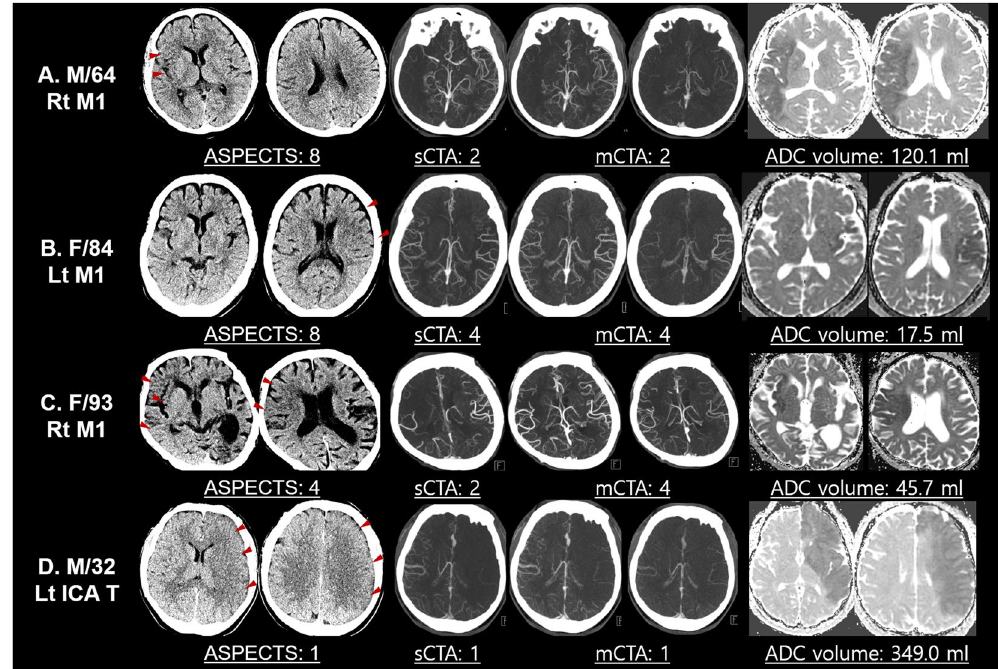
Figure 2. Illustrative cases of combined interpretation of ASPECTS and CTA-based collaterals in the estimation of infarct core volume. ( A ) While the ASPECTS score was high, it showed discrepancies with collateral grades. In this patient, MR ADC revealed a large infarct core. ( B ) This patient showed both a high ASPECTS score and CT collateral grade. MR ADC revealed a small infarct core, illustrating the importance of combined interpretation of ASPECTS and collateral grade. ( C ) While both ASPECTS and sCTAc grades suggested large infarct cores, mCTAc grade showed favorable pial collaterals. MR ADC revealed an intermediate infarct core. This case illustrated the importance of mCTAc for detecting larger infarct cores. ( D ) Low ASPECTS score and low collateral score predicted a high infarct core volume, as illustrated. ASPECTS, Alberta stroke program early CT score; CTA, computed tomographic angiography; MR, magnetic resonance; ADC, apparent diffusion coefficient; sCTAc, single-phase CT angiography collateral; mCTAc, multiphase CT angiography